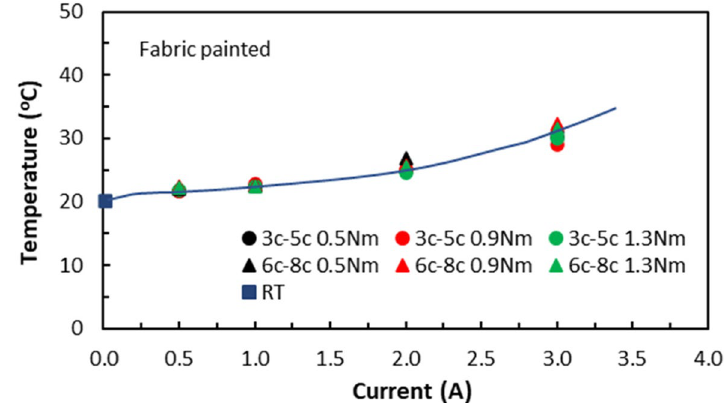
Fig. 9 Variations of raised temperature with current on the laminate surfaces of painted in-plane specimens